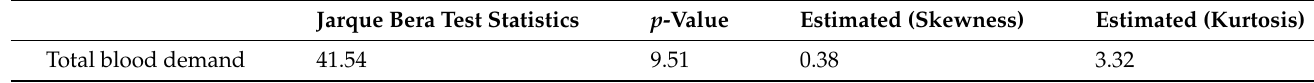
Table 8. Jarque–Bera test for normality of